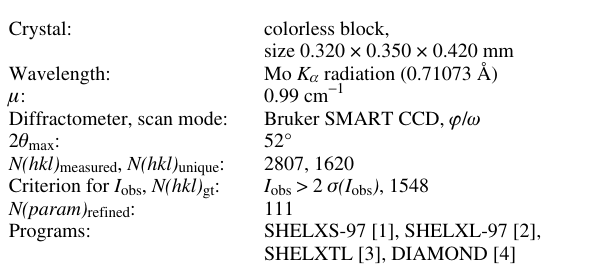
Table 1. Data collection and handling.